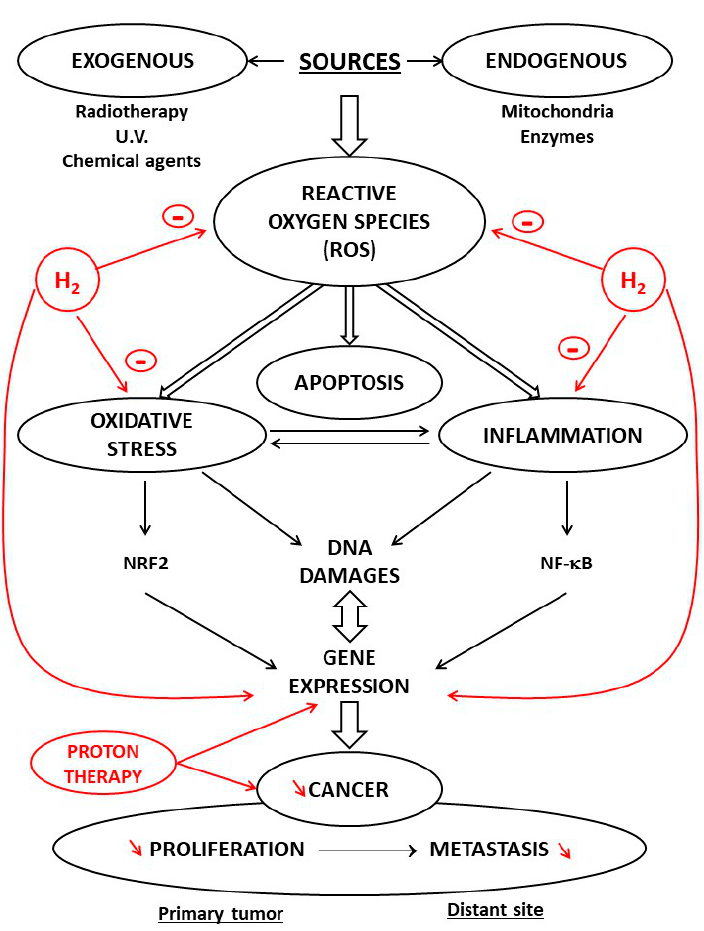
Figure 2. Effects of proton and H 2 therapies on oxidative stress and inflammation in carcinogenesis. reactive oxygen species (ROS) via oxidative stress and inflammation promote carcinogenesis in cells with defective signaling factors. A crosstalk exists between oxidative stress and inflammation; this interconnection is associated with activation of NRF2 and NF- κ B. Protons induce perturbations of gene expression inhibiting the cancer progression processes of invasion. H 2 reduces oxidative stress, exerts anti-inflammatory effects, and acts as a modulator of apoptosis. It scavenges ROS and, penetrating biomembranes, reaches cell nuclei. It modulates signal transduction implicated in proliferation and metastasis processes.